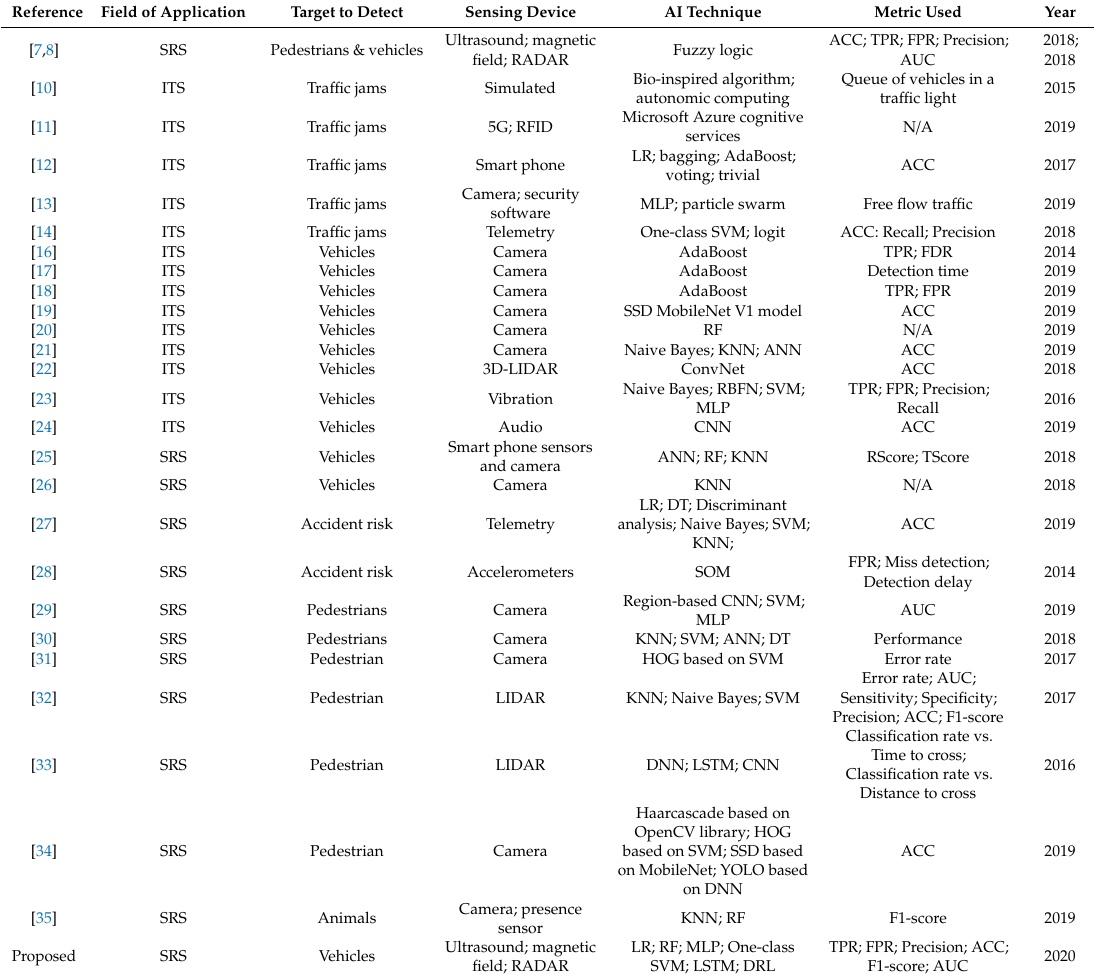
Table A1. Features of related work discussed in Section